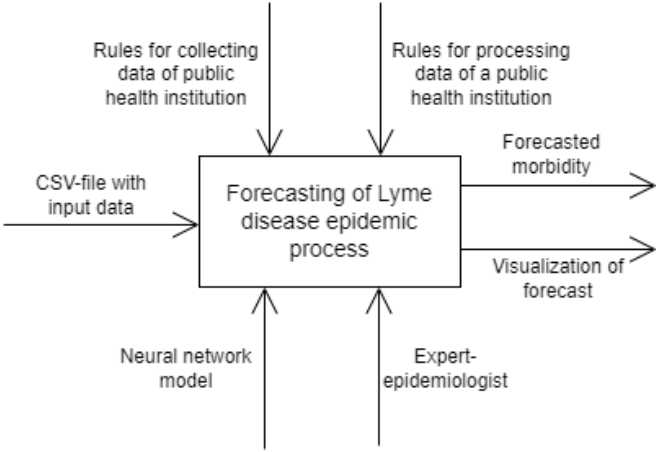
Figure 4. The context diagram of a software product.